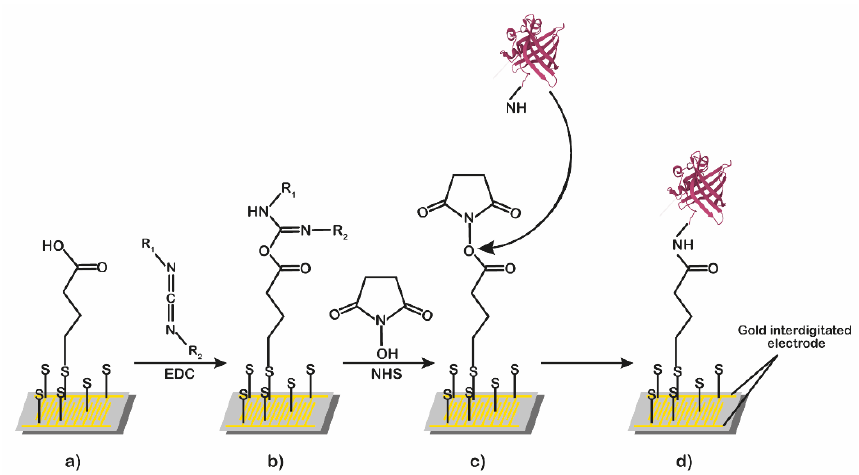
Figure 2. Schematic representation of surface derivatization and functionalization process. The gold surface derivatized with α -lipoic acid ( a ) was treated sequentially with a mixture of EDC/NHS ( b ), and then with a solution of pOBP ( c ) or GlnBP ( d ).